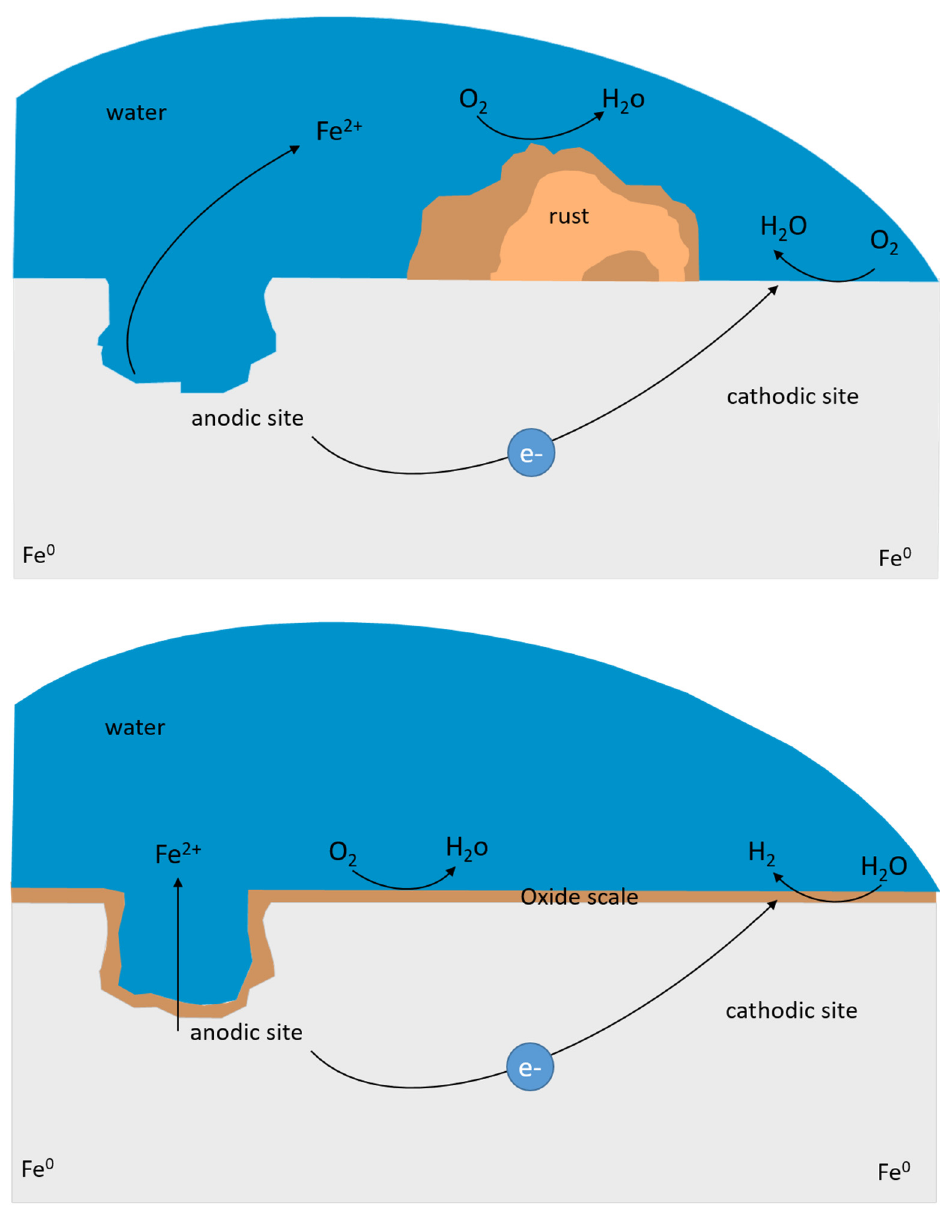
Figure 1. Sketch of the electro-chemical process of iron corrosion as influenced by the abundance of water and dissolved O 2 before ( top ) and after ( bottom ) the generation of a porous oxide scale. The porous oxide-film is a diffusion barrier to all dissolved species, including O 2 .